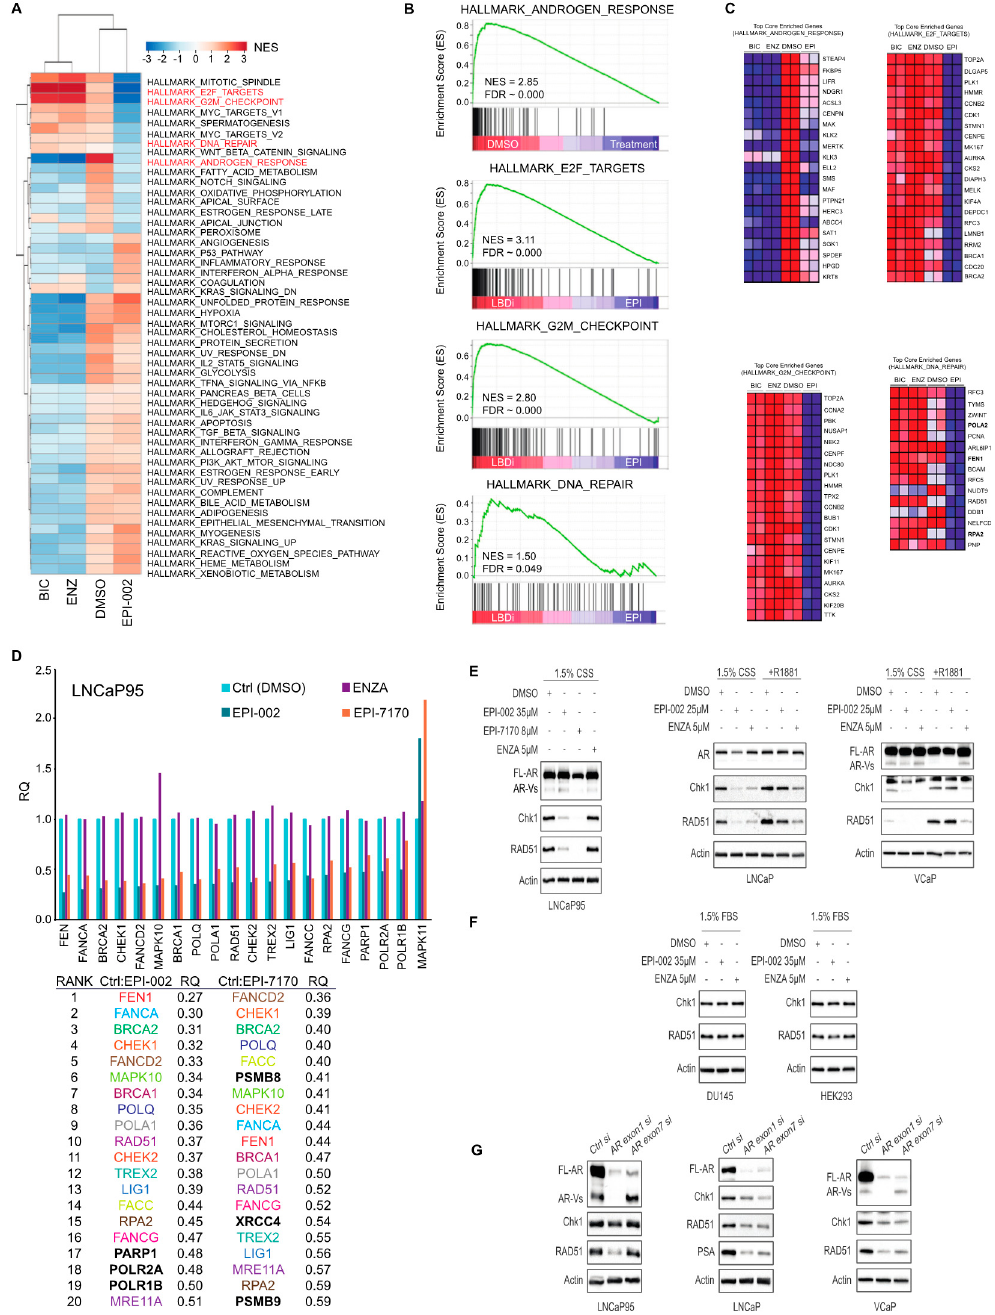
Figure 3. Ralaniten and EPI-7170 selectively inhibit the DNA damage repair (DDR) pathway in prostate cancer cells that express both full-length AR and AR-Vs. ( A ) Heatmap displaying normalized enrichment scores (NES) obtained from a gene set enrichment analysis (GSEA) of LNCaP cells treated with bicalutamide (BIC, 10 µ M), enzalutamide (ENZA, 5 µ M), ralaniten (EPI-002, 35 µ M) or DMSO vehicle and stimulated with 1 nM R1881. Expression levels were normalized against control samples (DMSO/EtOH). Gene sets were restricted to MSigDB set H (hallmark gene sets). Gene sets with nominal p < 0.05 and false discovery rate (FDR) q < 0.05 were considered significant. ( B ) Enrichment plots from selected gene sets showing enriched genes in DMSO control vs. treated samples. All three